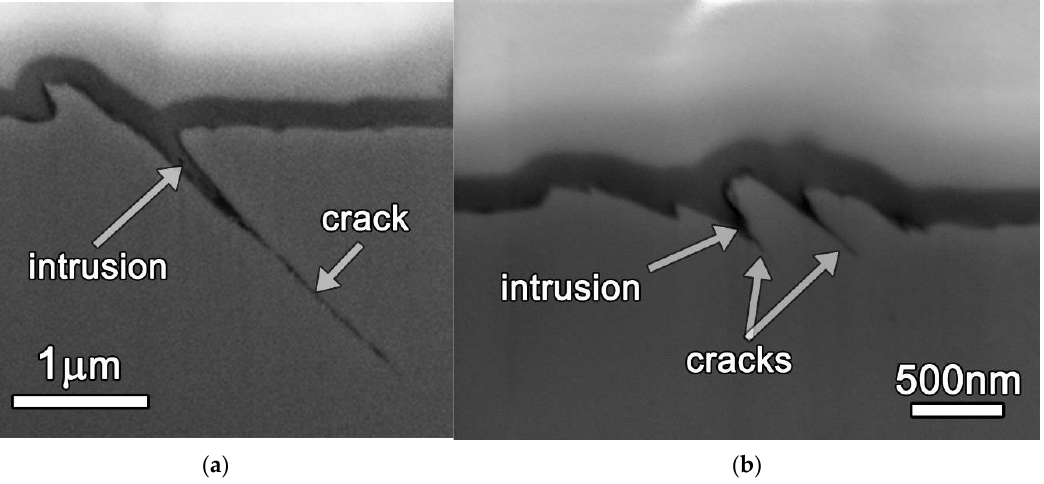
Figure 15. Detail of the FIB cuts of fatigued Sanicro 25 steel showing the profiles of PSMs and starting cracks; ( a ) PSM consisting of extrusion and intrusion and a crack starting from the tip of the intrusion, ( b ) PSM with cracks starting from intrusions.